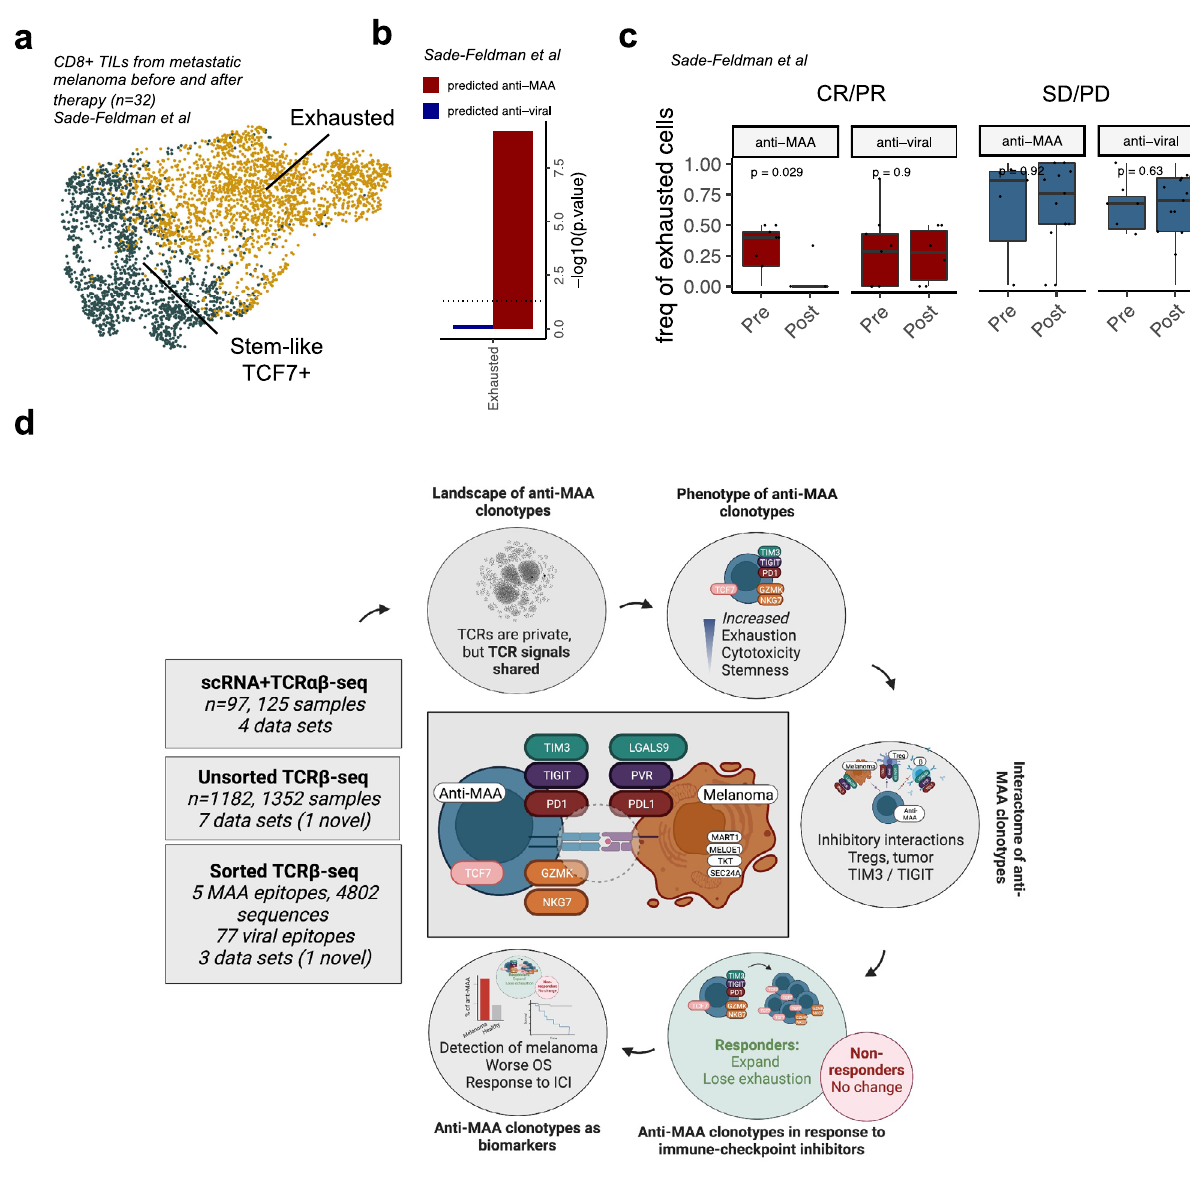
Fig. 4 | The exhausted phenotype of anti-MAA T cells is reinvigorated with immune checkpoint-therapies in responding patients, unlike in anti-viral T cells. a UMAP projection of expression pro fi les of CD8 + tumor-in fi ltrating lym- phocytes with identi fi ed TCR from 48 metastatic melanoma samples from 32 patients before and after anti-PD1 with or without anti-CTLA4, therapy, colored by cluster.(Datafromref.31). b Barplotshowingtheenrichmentofanti-MAAandanti- viral clonotypes to exhausted T cell phenotype as P -values from one-sided Fisher ’ s exact test. (Data from ref. 31). c Boxplot showing the frequency of exhausted cells before and after immune checkpoint therapy. Patients were divided by the response (responders n =18, including complete response [CR] and